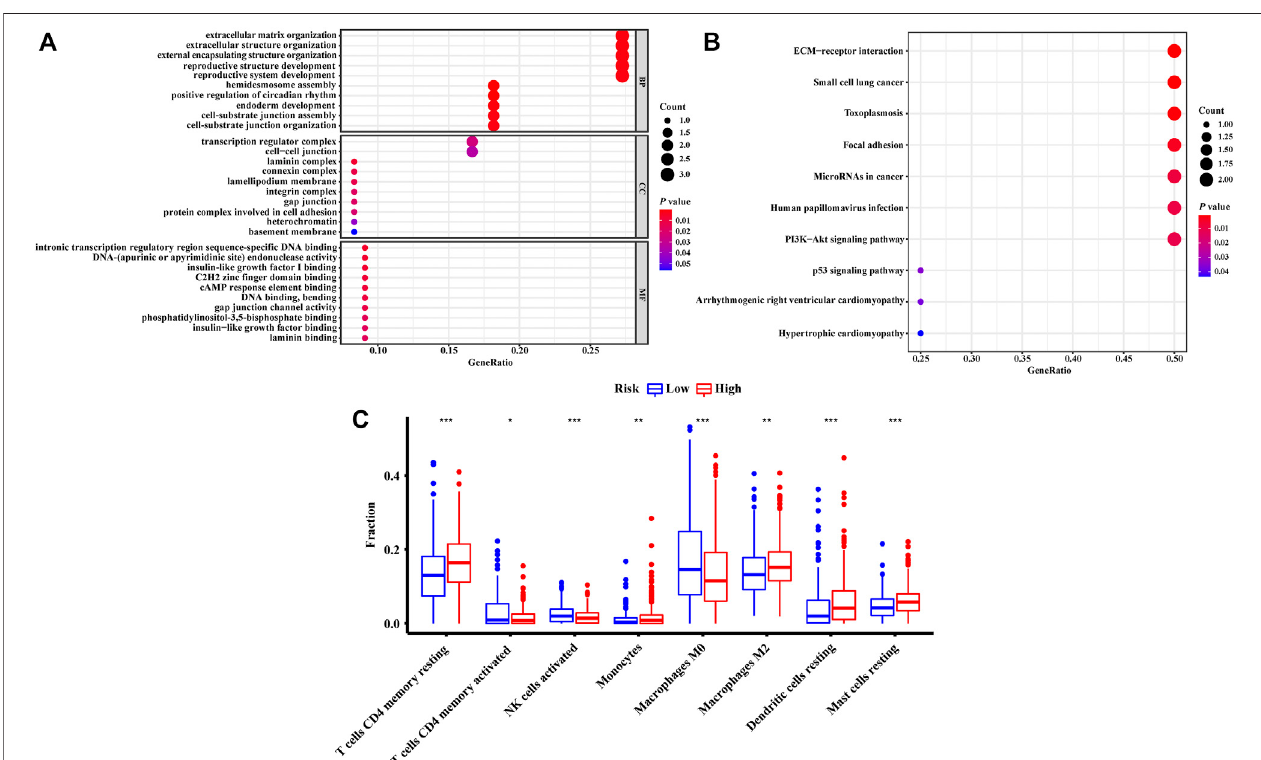
FIGURE 7 | Functional enrichment analysis and the characteristics of immune in fi ltration of different groups de fi ned by the signature. The GO terms (A) and KEGG terms (B) enriched by the co-expressed genes related to necroptosis-related lncRNA. (C) Differences in abundance of tumor-in fi ltrating immune cells among two risk groups strati fi ed by the necroptosis-related lncRNA